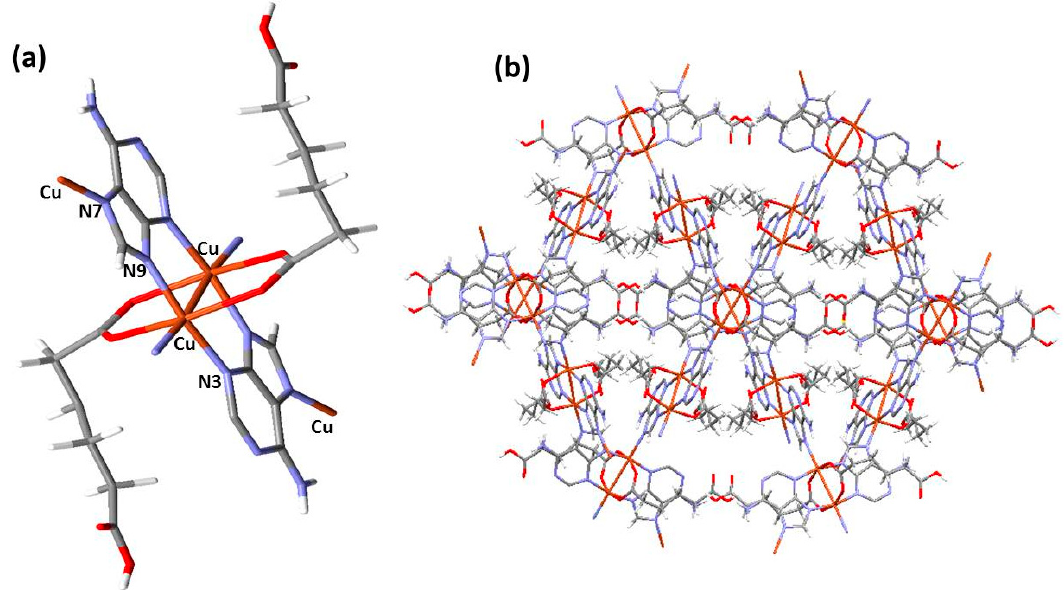
Figure 2. Different views of the structure of {[Cu 2 ( μ 3 -adeninato) 2 ( μ -Hadip) 2 ]} n ( 1m ) (ref. code KEBPOY from the Cambridge Structural Database, CSD) [26]. ( a ) Fragment of the repetition unit of compound 1m that shows the paddle-wheel motif. To clarify nitrogen atoms are in blue, copper atoms are in orange, carbon atoms are in grey, oxygen atoms are in red, and hydrogens atoms are in white. ( b ) The perspective view of the overall 3D structure. The structural disorder has been omitted in the drawing for clarity.